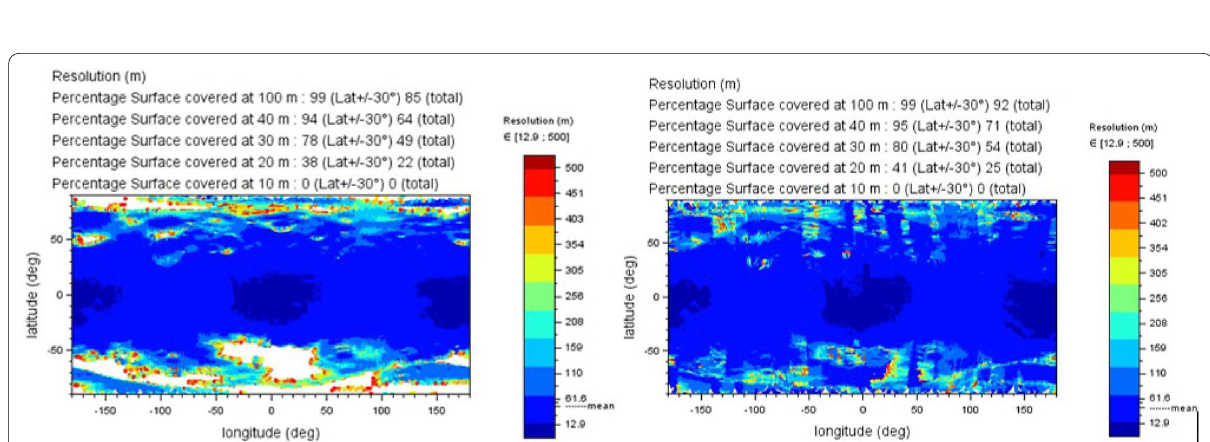
Fig. 20 Left: example of geometric resolution for equatorial QSO‑M Nov 2025 (β 3°). Most of Phobos is covered with high resolution. Zones in = white cannot be observed because of MMX equatorial trajectory and Phobos flat shape on highest latitudes (poles). Right: example of geometric resolution for 3D‑QSO‑M Sep–Oct 2026 (β 6°). Highest latitudes (poles) can be observed thanks to MMX 3D trajectory that allows visibility of = − high